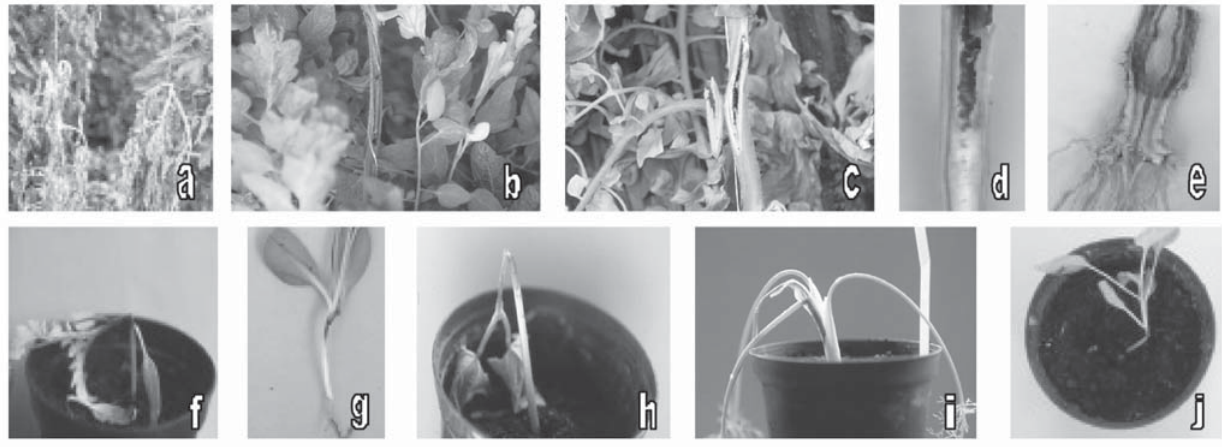
Fig. 1. Symptoms in naturally infected tomato plants: (a) wilted plants; (b) brown/black longitudinal stem lesions; (c and d) stem hollowness and vascular tissue discoloration; (e) symptoms on a grafted plant. Symptoms in artificially inoculated plants: (f) tomato, (g) artichoke, (h) bean, (i) fennel and (j) pepper